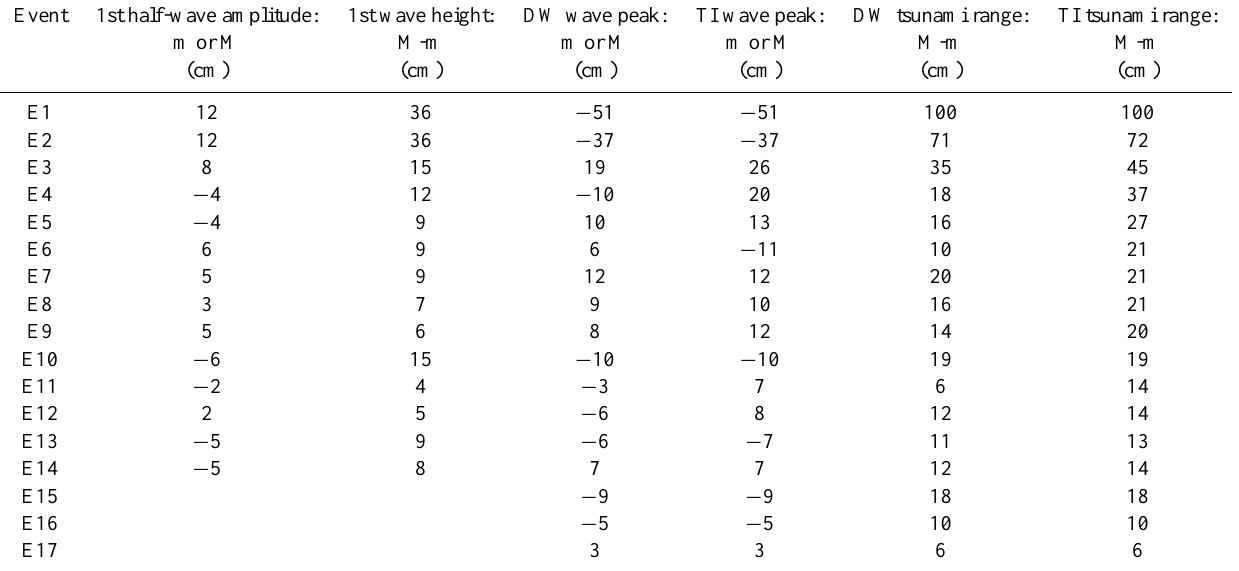
Table 3. Tsunami amplitudes and heights. The minimum and maximum sea elevations are denoted by m and M respectively: they refer to the first wave, to the Detection Window DW (i.e. the 3h long interval within which a TEDA detection is considered successful), and the Tsunami Interval TI (i.e. the interval where tsunami signal is present). In particular, in the various columns the following quantities are given: the 1st half-wave amplitude (positive for a crest and negative for a trough); the 1st wave height; the largest peak in the DW; the largest peak in the whole TI; and the tsunami range, i.e. the difference between the maximum and the minimum in the DW and in the TI. Notice that events have been numbered according to the descending range of the tsunami waves within TI (last column). Given the difficulties in identifying the first wave for events E15, E16 and E17, the respective information is not given.